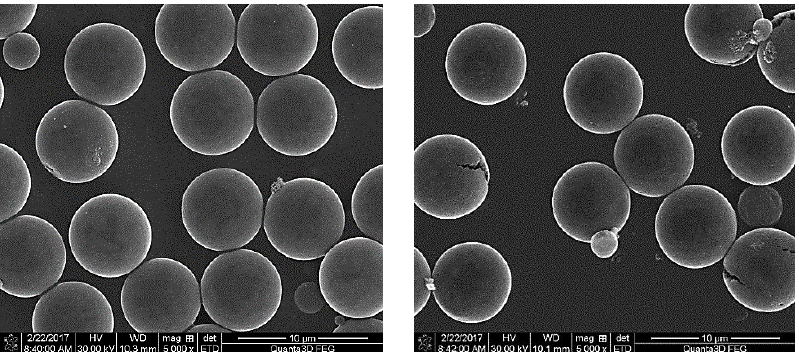
Figure 2. SEM micrographs of GE microspheres.